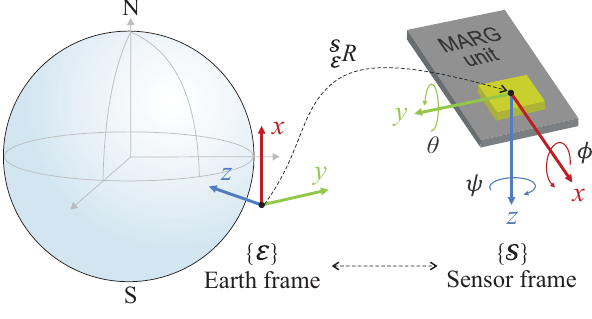
Figure 1. Relative orientation between the earth frame (